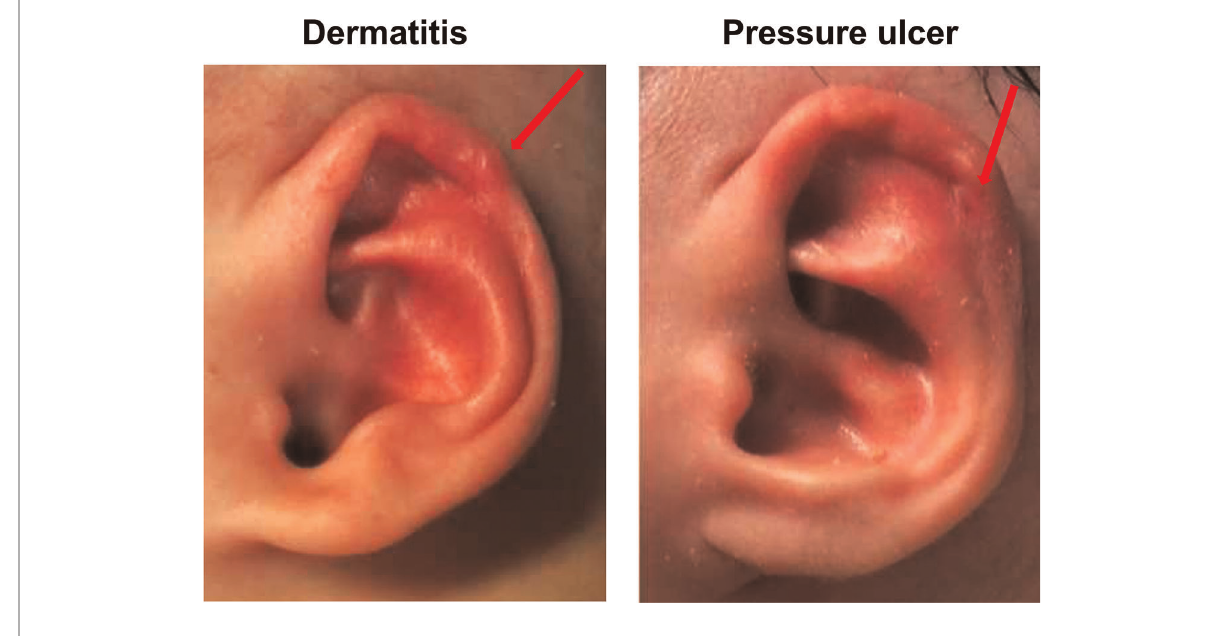
FIGURE 4 Complications of the EarWell system.